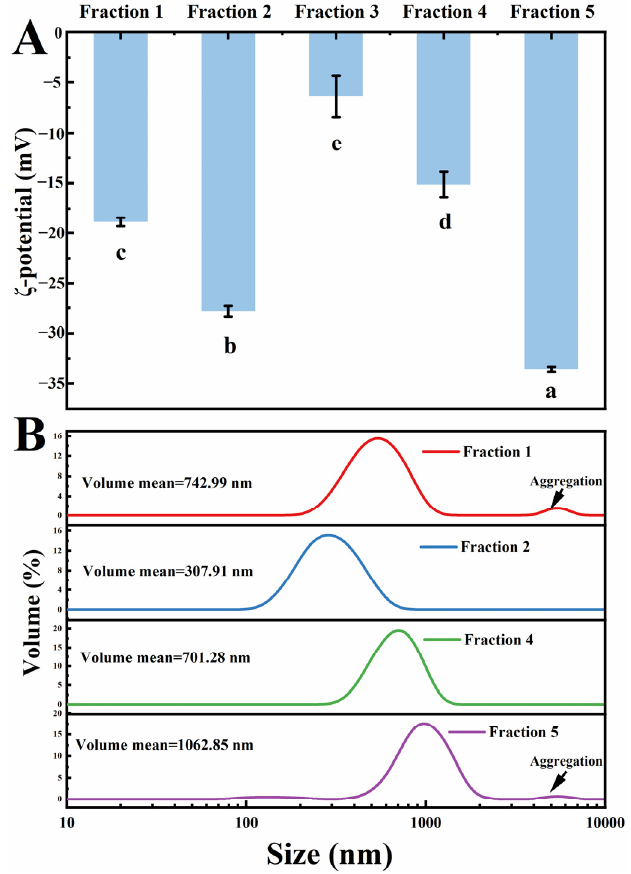
Figure 3. ζ -potential ( A ) and volume particle size distribution ( B ) of flaxseed protein-polysaccharide natural fraction s . Comparisons were performed between values of the same serious and those without same letter(s) differed significantly at p < 0.05.